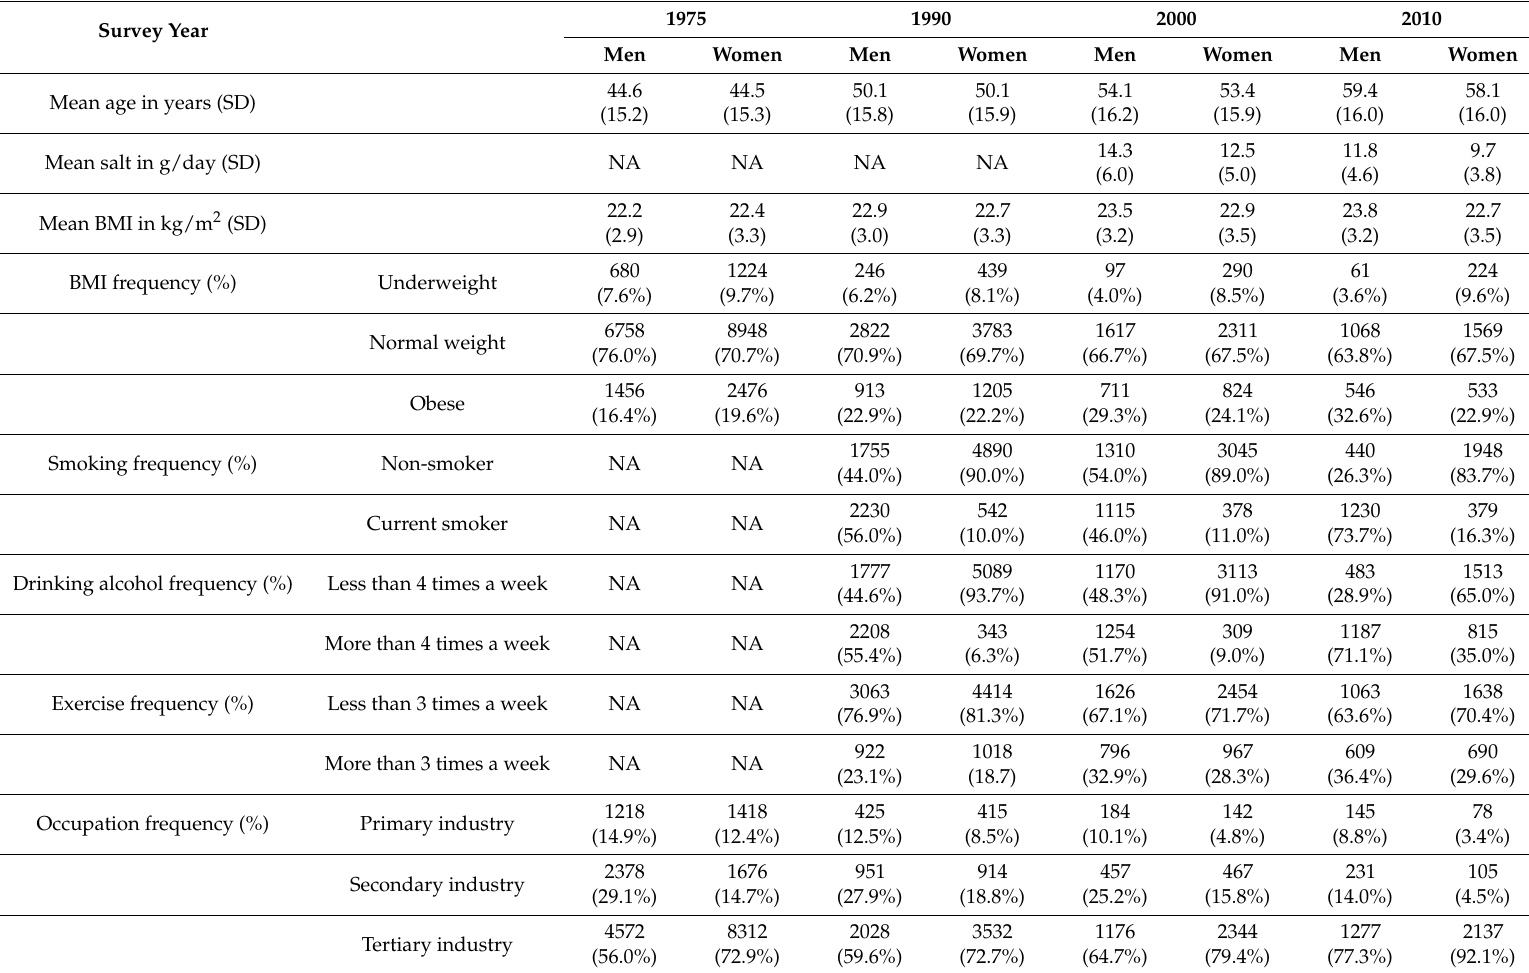
Table 3. The means and proportions of risk factors by sex for the survey years of 1975, 1990, 2000, and